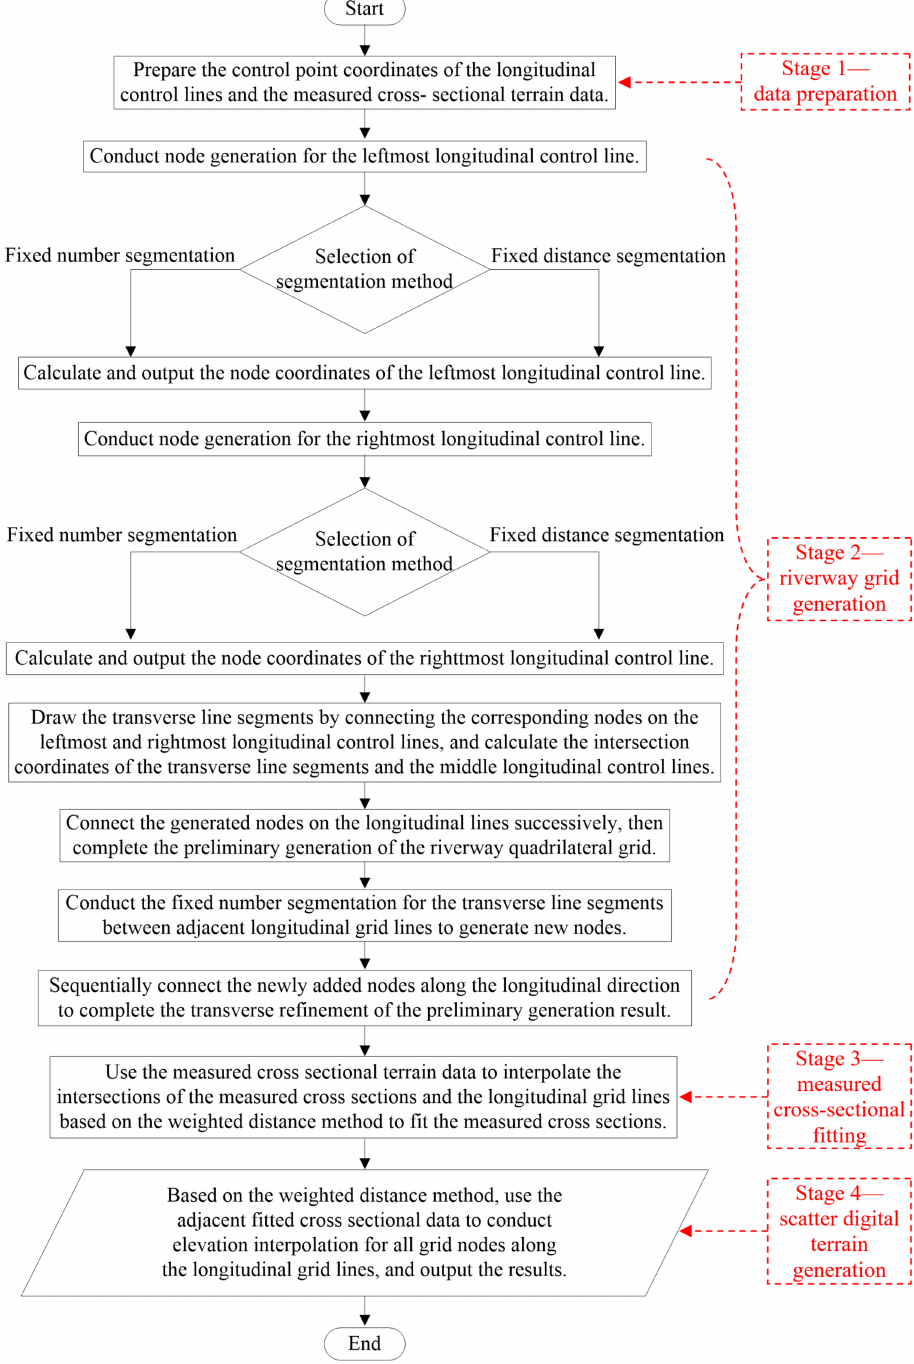
Figure 1. Digital terrain reconstruction process. The measured cross-sectional terrain data mainly include the cross-sectional left and right endpoint coordinates (the left and right sides are defined according to the flow direc- tion), the measured point elevations and the horizontal distances between the measured points and the corresponding left endpoint (in Figure